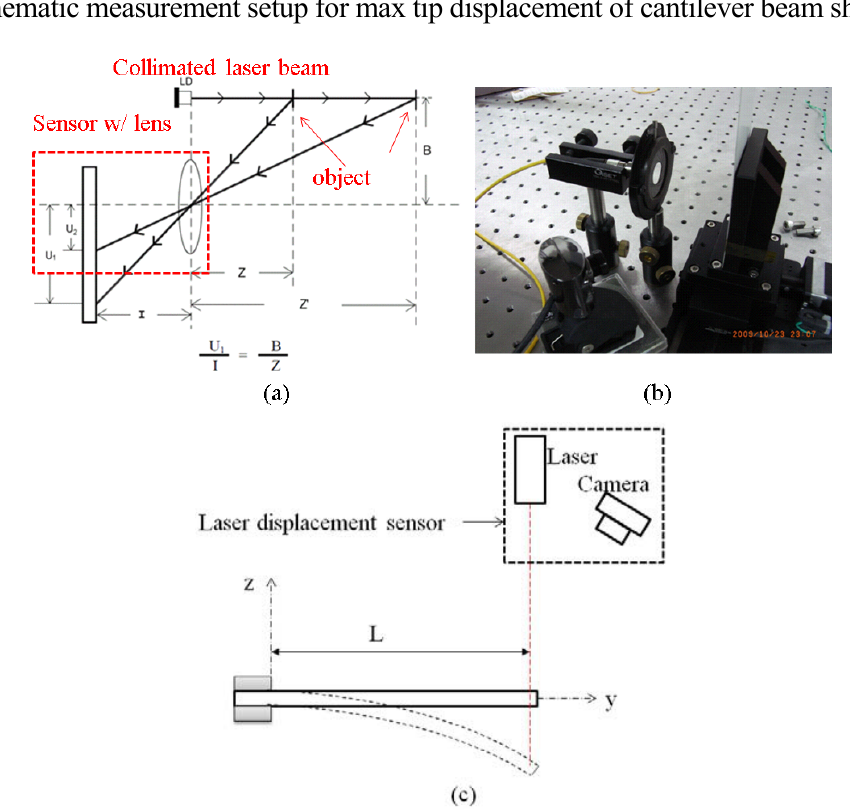
Figure 7. The laser displacement based on triangulation measurement method. ( a ) the triangulation measurement method; ( b ) the real components of the laser displacement sensor; ( c ) the schematic measurement setup for max tip displacement of cantilever beam shape